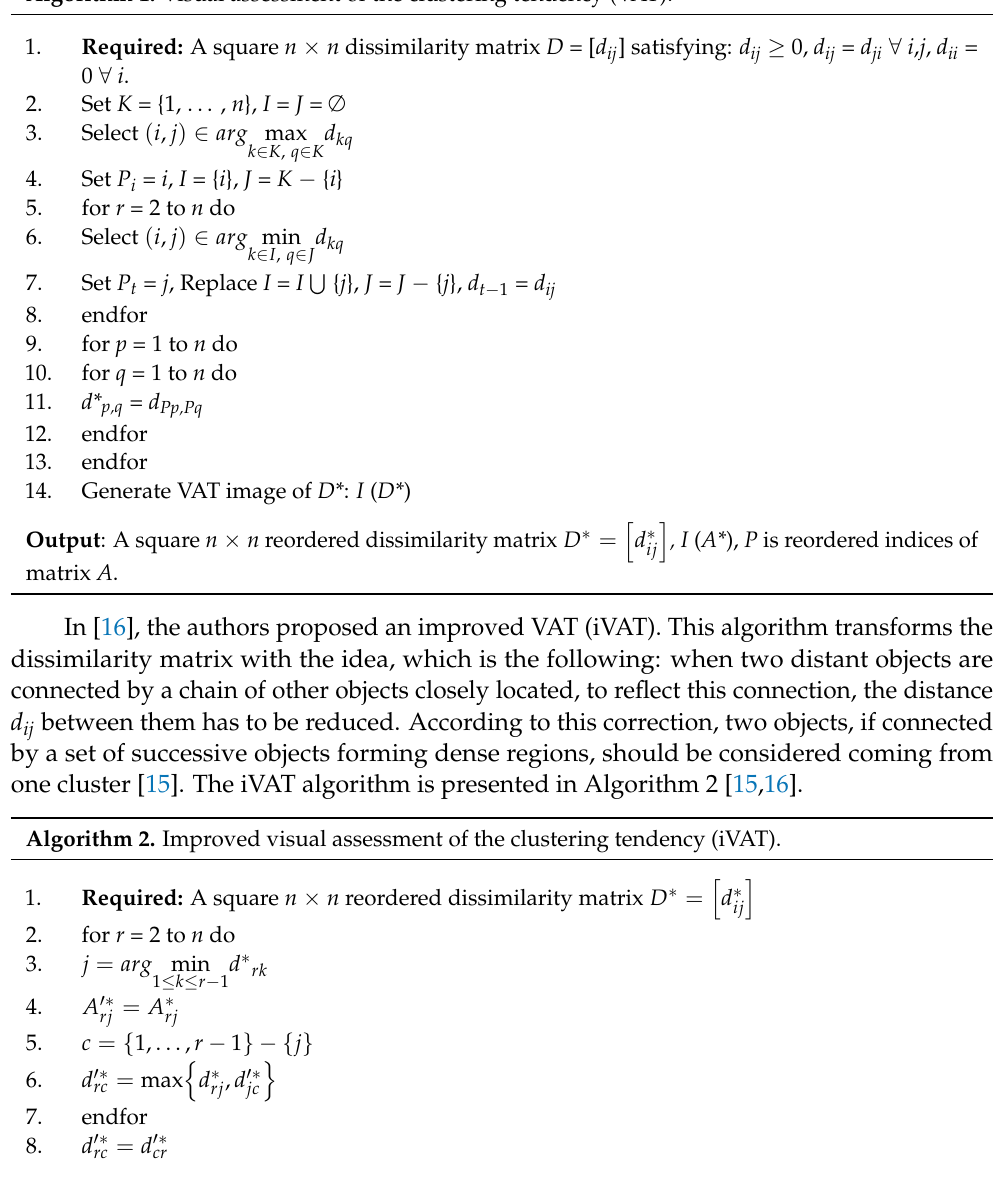
Algorithm 1. Visual assessment of the clustering tendency (VAT).